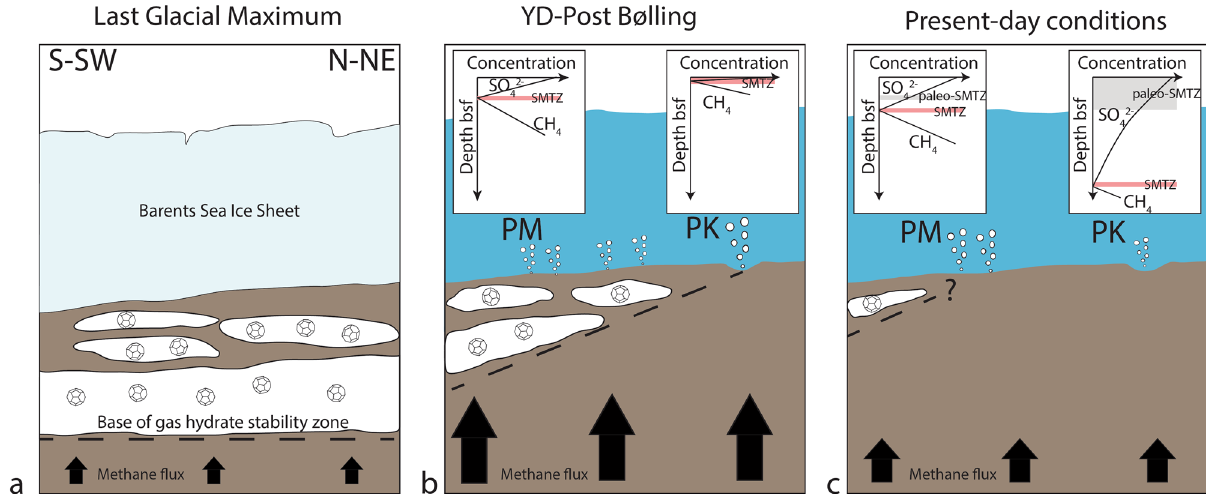
Figure 5. Schematic evolution of methane seepage at LFC after the LGM. ( a ) During the LGM, grounded ice sheet maintained gas hydrates stable for hundreds of meters below the seafloor. ( b ) The retreat of the ice sheet triggered hydrate destabilization and enhanced methane fluxes toward the seafloor causing the shoaling of the SMTZ. ( c ) An overall decrease in methane flux during the Holocene was recorded at both studied areas. PM = Ploughmark area; PK = Pockmark area. The modern SMTZs and paleo-SMTZs are highlighted in red and grey color, respectively. Not in would carry a progressively lighter δ 18 O composition following temperature-dependent fractionation. In the present study, the aragonite sample collected from core 1143GC yielded a δ 18 O = 5.0‰, indicating a contribution from exotic fluids carrying a heavier oxygen isotopic signature compared to coeval seawater. Calcite samples in core 1141MC show values of 5.3‰ and 5.0‰, indicating a limited contribution from 18 O-enriched fluids which resulted in an isotopic composition similar to the aragonite sample of core 1143GC. We calculated the gas hydrate stability zone (GHSZ) in the Pockmark area after 14.5 cal ka BP to validate whether gas hydrate dissociation may explain the analytical data (full parameters are reported in the methods section). Results indicated that pure methane hydrate was not stable in the Pockmark area. However, as frequently observed in present-day settings in the SW Barents Sea 68 , inputs of thermogenic gas to the GHSZ increase the stability field due to larger concentration of higher-order hydrocarbons. By assuming a molecular gas composition similar to the one measured in the Late Triassic Sandstones in well 7321 8–1 (http://factp age.npd.no) we obtained a 10–80 m-thick GHSZ, which indicates that the Pockmark area was located at the edge of gas hydrate stability. Therefore, we argue that MDAC from the Pockmark area recorded the influence of past gas hydrate destabiliza- tion. The majority of gas flares mapped in the water column at LFC are in the Ploughmark area (Fig. 1b) where pore water sulfate profiles show the shallowest SMTZ (Fig. 3c; Supplementary Fig. S1). The present-day edge of hydrate stability zone calculated using present-day average bottom water temperature of 2.5 ℃ crosses this area (10–60 m-thick GHSZ), however, to date there is no evidence for the presence of gas hydrates in the sub-seafloor to validate the results of this model. Chronostratigraphic constraints indicate that hydrate destabilization started during the Younger Dryas—post Bølling period (later than 14.5 cal ka BP) and continued during part of the Holocene. Even though precise timing cannot be established through U/Th analysis due to the very high detrital content in the carbonates, our results are the first to validate the model proposed by Crémière et al. 23 where widespread destabilization of gas hydrates in the SW Barents Sea 23 is linked to the collapse of the Late Weichselian Ice Sheet. During the Last Glacial Maxi-